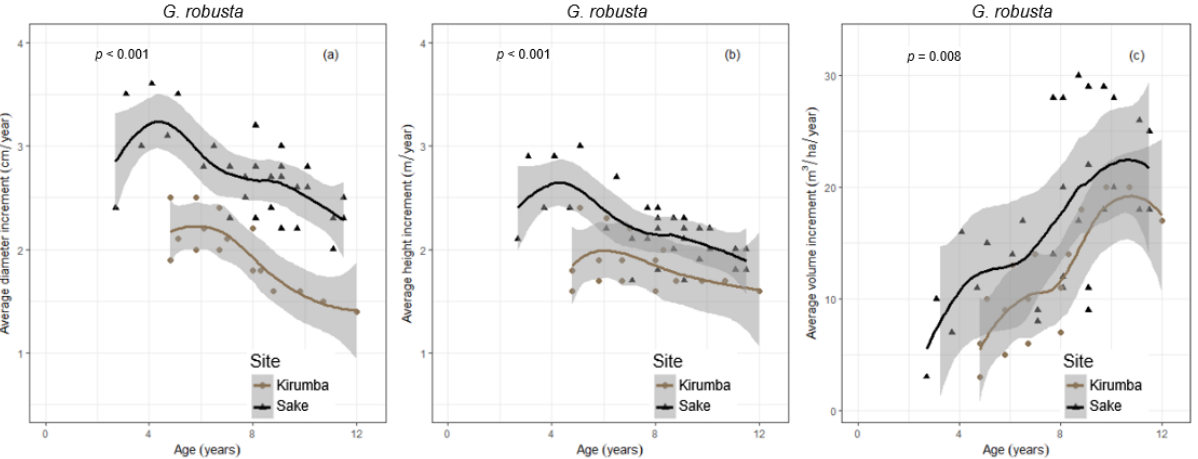
Figure 6. Average increments in diameter ( a ), total height ( b ) and volume ( c ) in G. robusta plantations in Sake and Kirumba. The probability ( p ) given is that of Student’s t